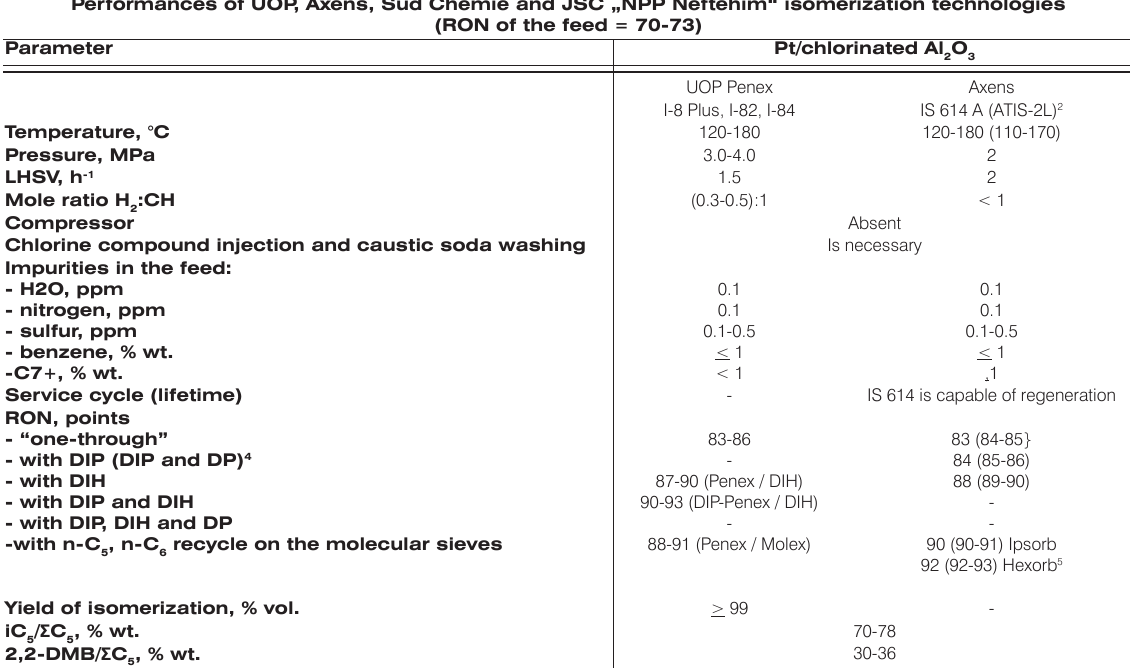
Table 1b. Performances of Pt/chlorinated Al Performances of UOP, Axens, Süd Chemie and JSC „NPP Neftehim“ isomerization technologies